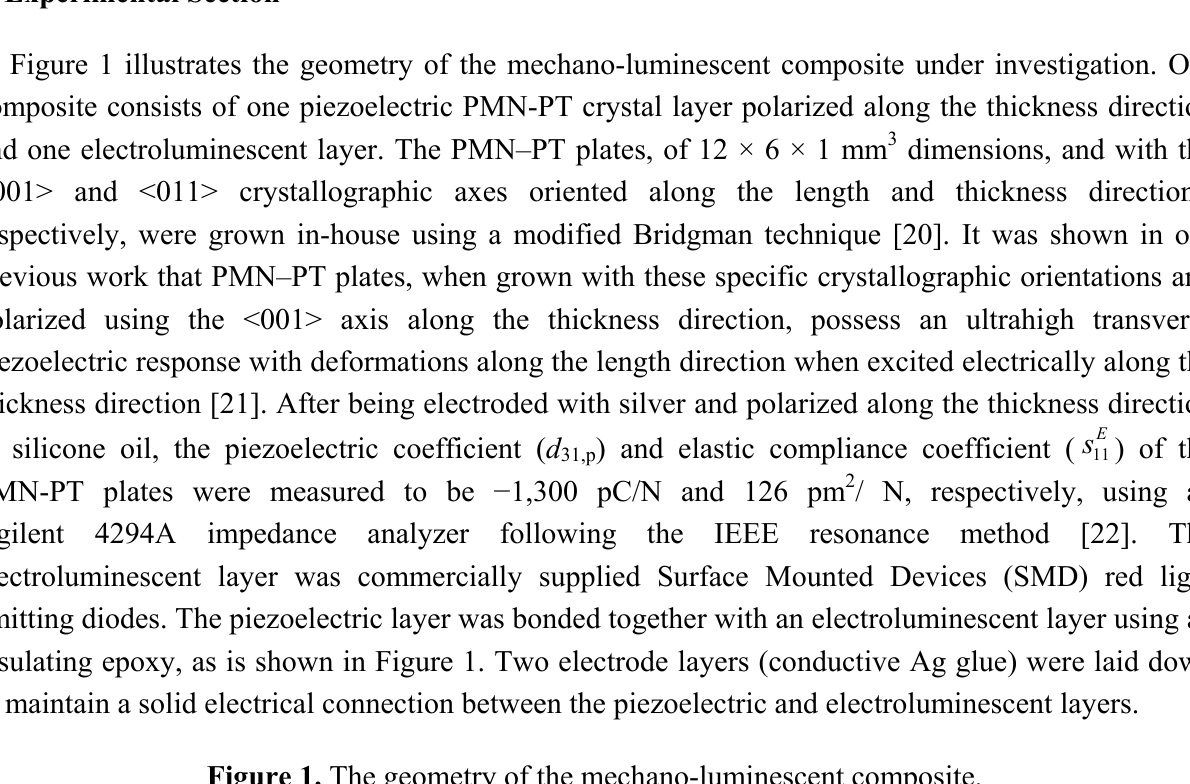
Figure 1. The geometry of the mechano-luminescent